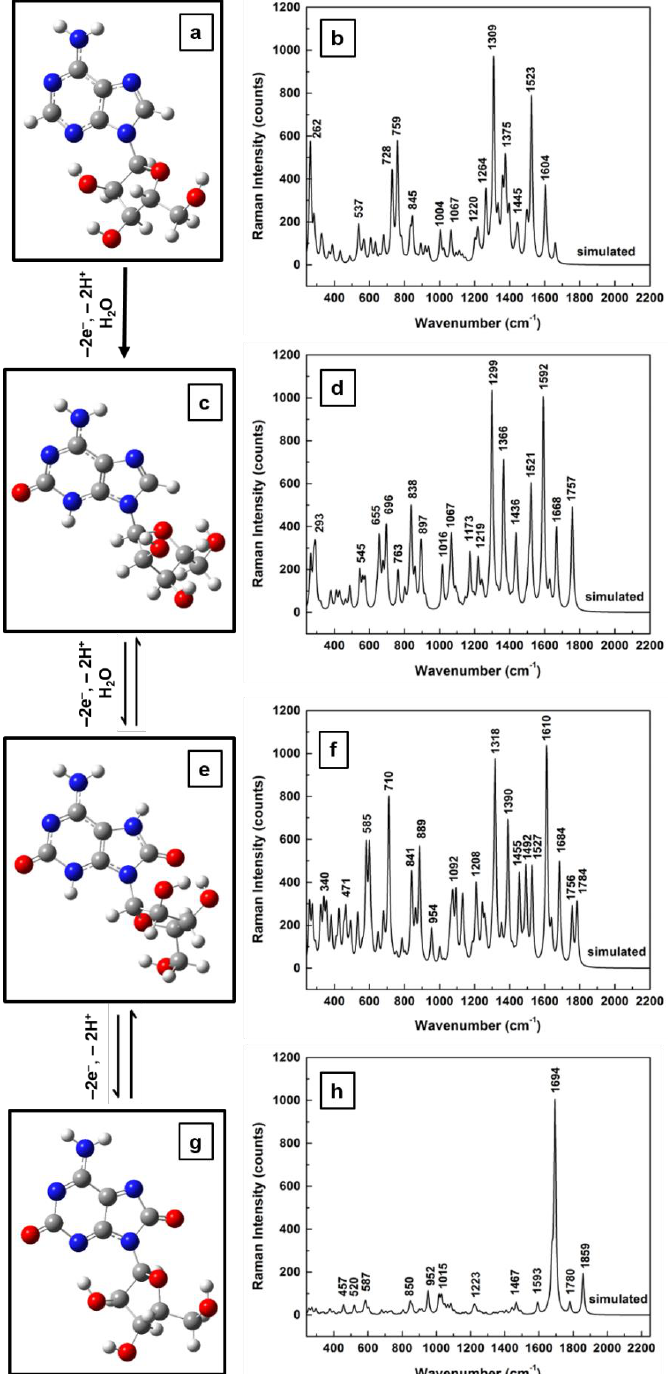
Figure 3. Structural representations of the sequential oxidation steps of the redox process of adenosine consisting of: ( a ) standard, neutral form; ( c ) result of first step of 2-electron oxidation; ( e ) result of second step of 2-electron oxidation, and ( g ) result of last step: fully oxidized adenosine. ( b , d , f , h ) Computed Raman vibrational spectra associated with ( a , c , e , g ), respectively.